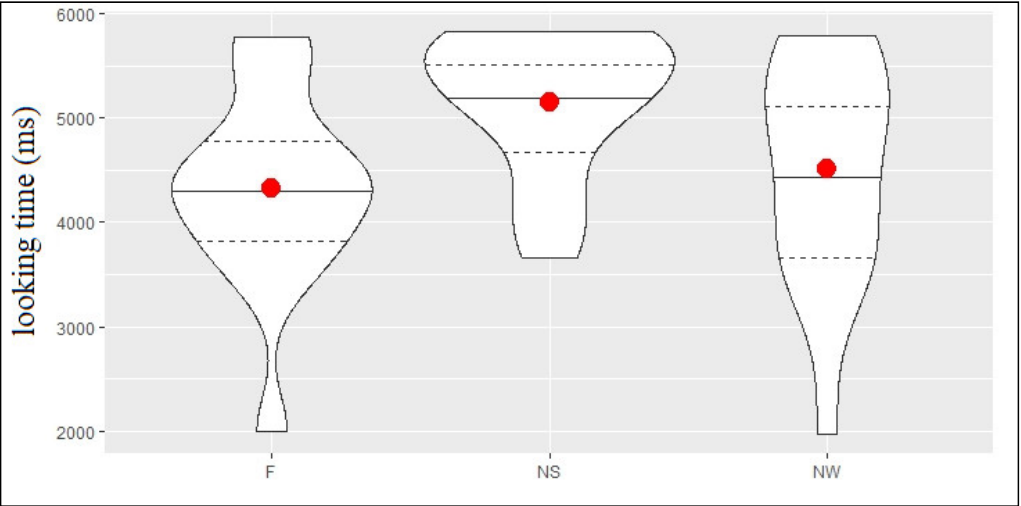
Figure 4. Violin plot for looking time in milliseconds during the familiar (F), novel strong (NS), and novel weak (NW) condition. Median, first and third quartile, and outliers are plotted. Table 4. Model comparison for predicting looking times during test phase conditions. Model RD dAIC